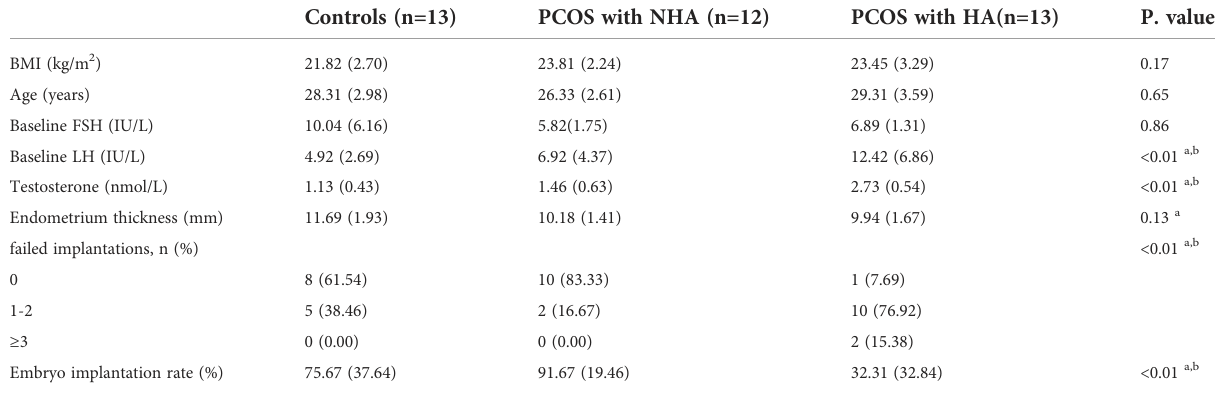
TABLE 3 Clinical characteristics of PCOS patients and controls.